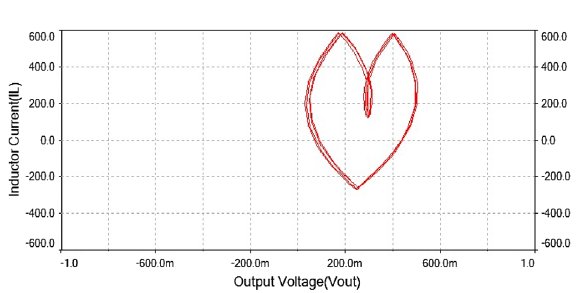
Figure 24. Phase portrait between I L vs V out at R L = 7.5 (cid:31) : period-2 attractor .